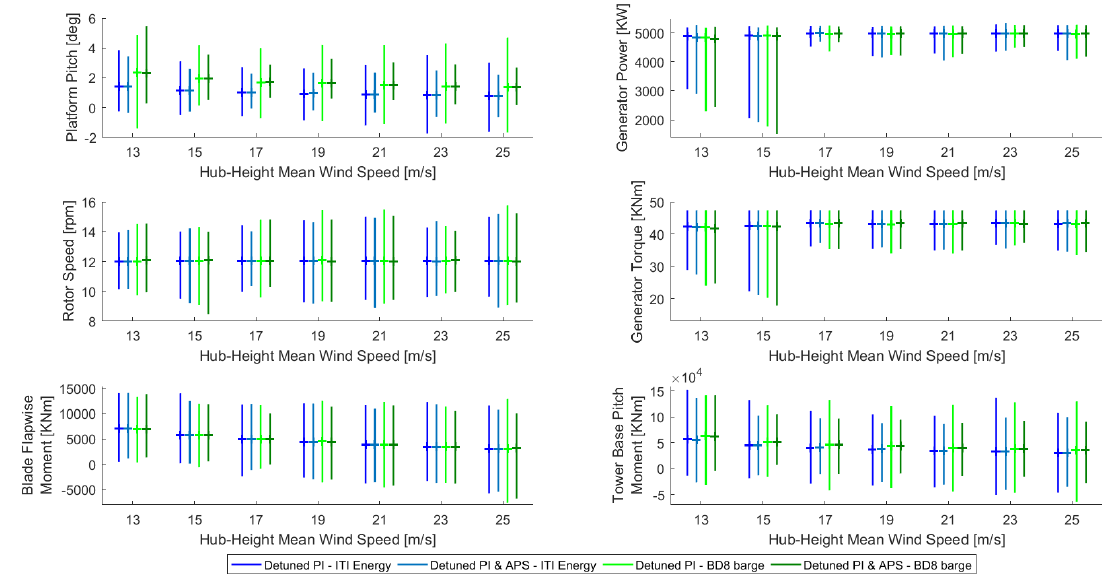
Figure 10. Candlestick chart summarising the most relevant variable values of all the time-domain simulation